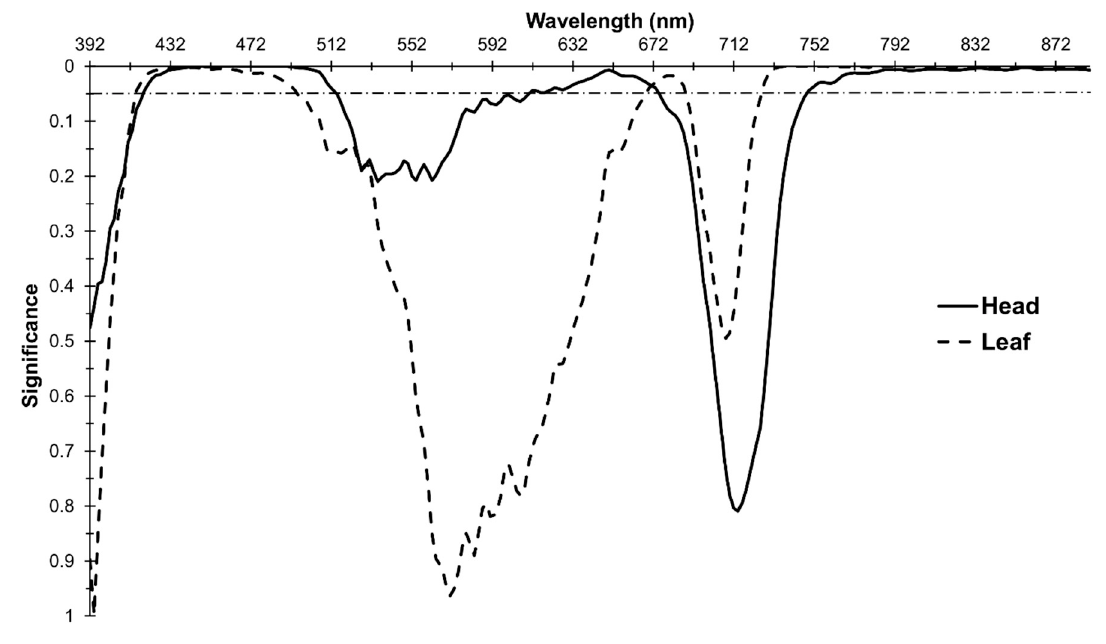
Figure 3. Probabilities corresponding to the impact of the frost treatment as a main effect on reflectance. Horizontal dashed line is at p = 0.05.